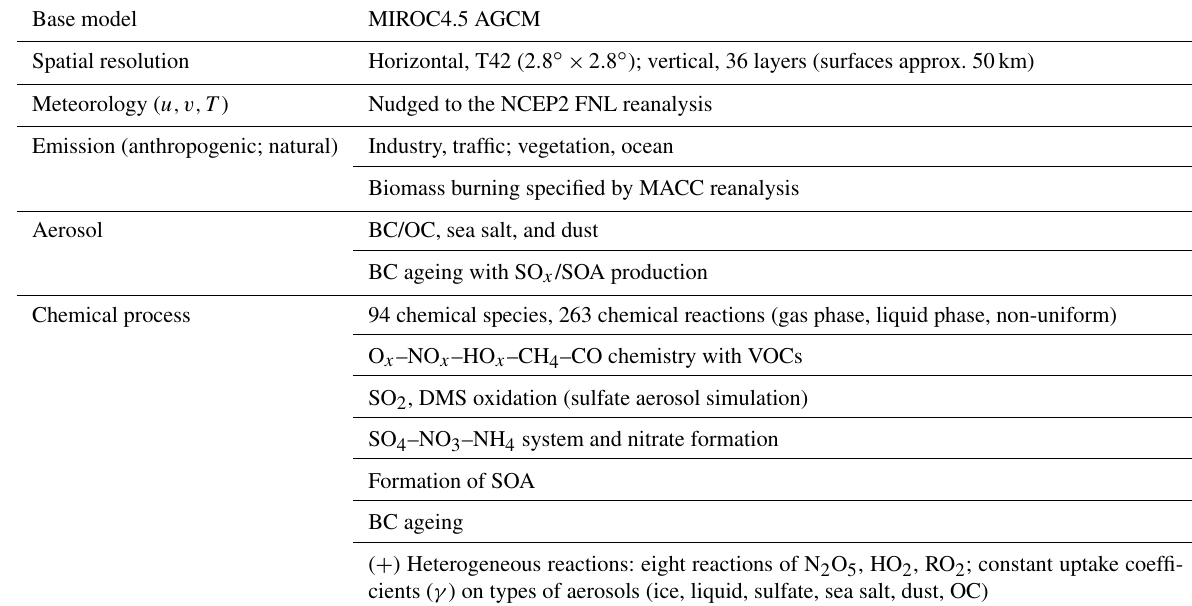
Table 1. Computation packages in the chemistry–climate model